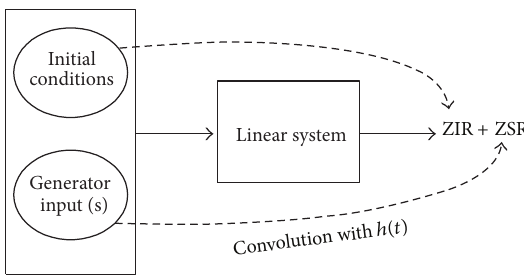
Figure 19: The generalized input includes both generator inputs and initial conditions. (This becomes trivial when the Laplace transform is used to transform a system scheme .) Considering the superposition of the output function of a linear system for such an input , we obtain the associated structure of the solution of the linear system in a form that is different from (3). Respectively, the output function is written as ZIR( 𝑡 ) + ZSR( 𝑡